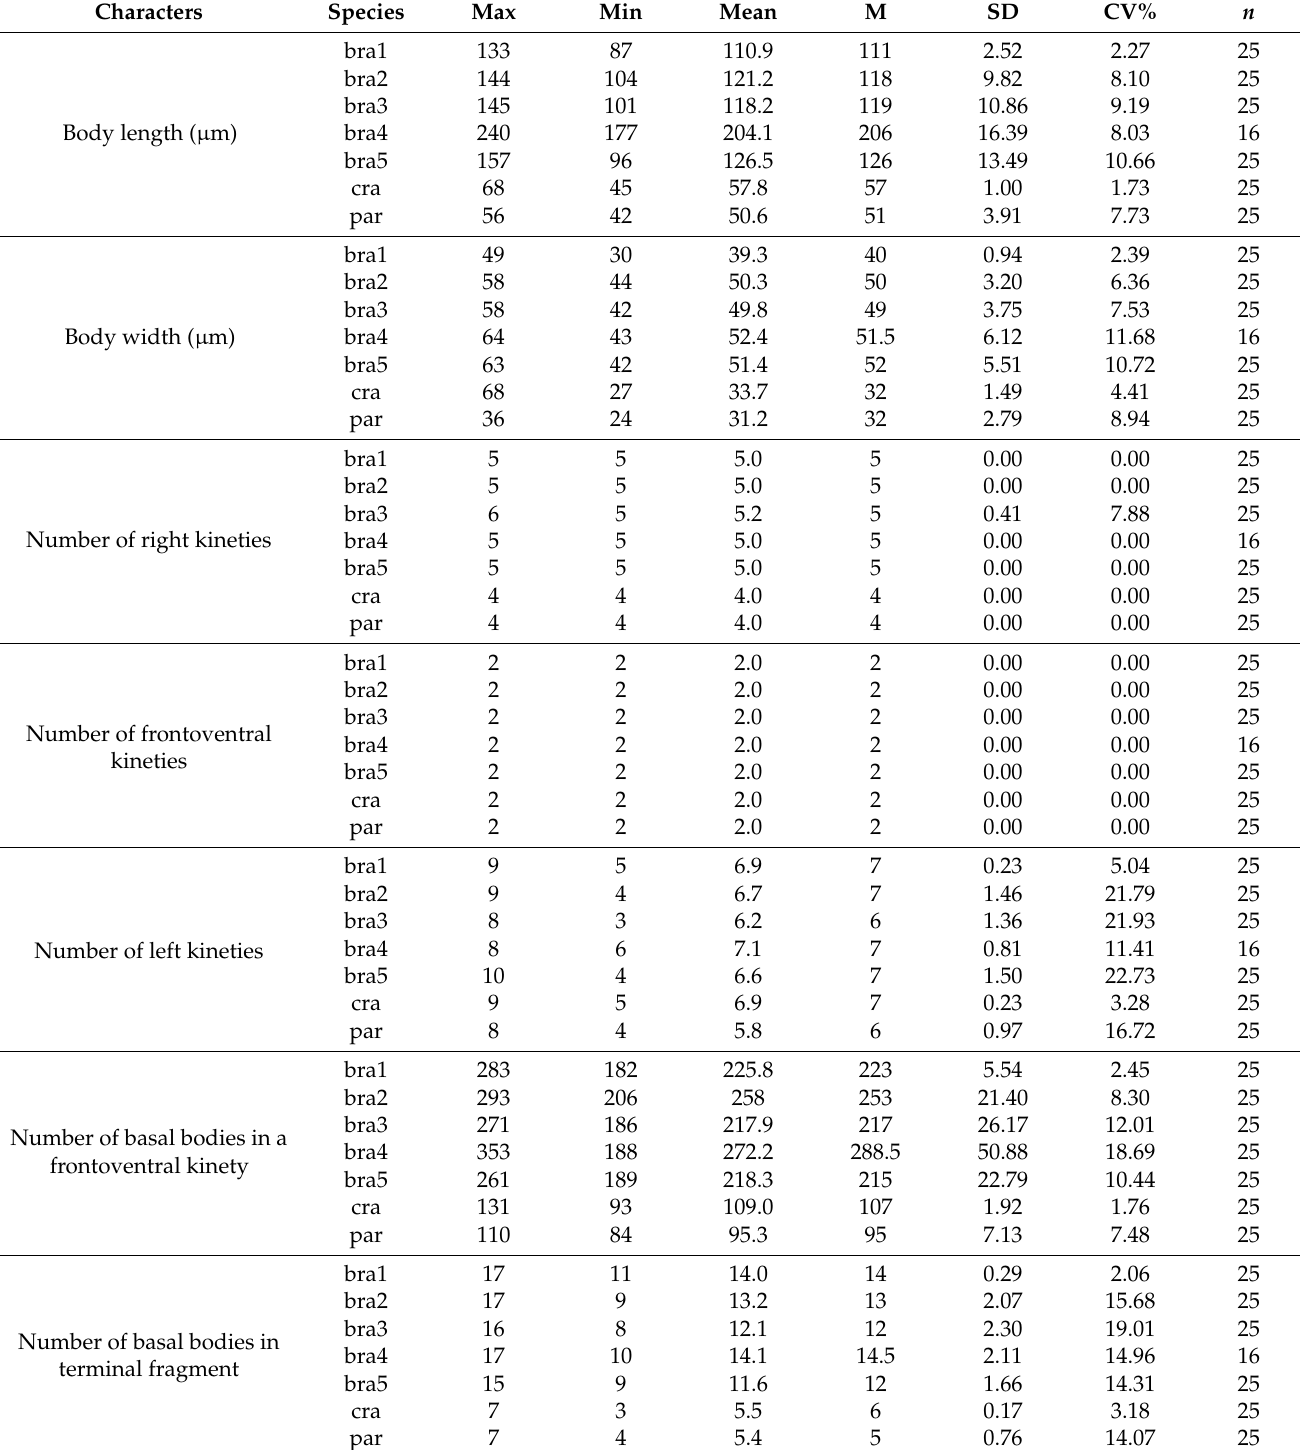
Table 1. Morphometric data on Dysteria paracrassipes n. sp. (par), D. crassipes (cra, Ningbo population), and D. brasiliensis (bra1, Ningbo population-I; bra2, Ningbo population-II; bra3, Ningbo